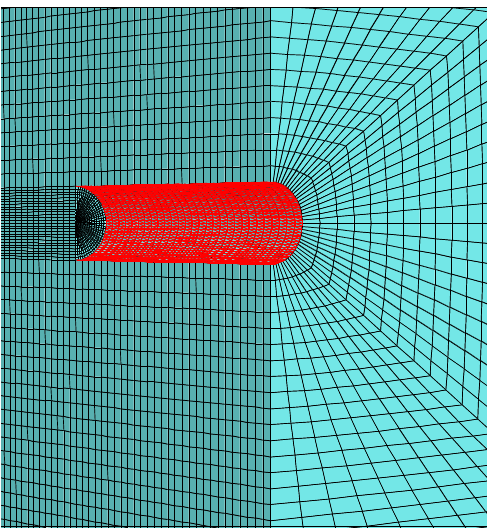
Figure 11. Tunnel segment lining defined as shell elements. Table 5. Excavation stages.